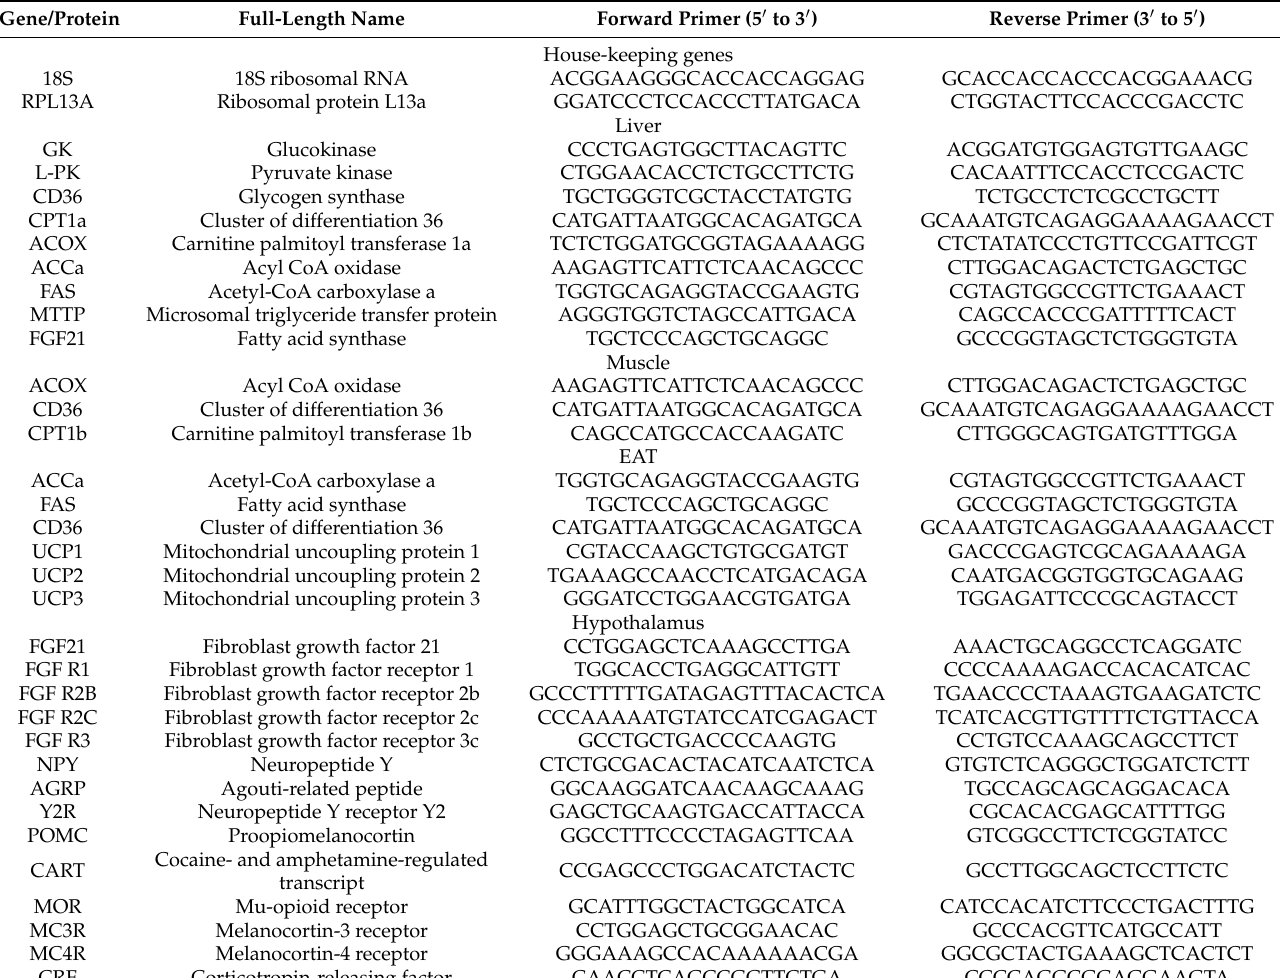
Table A3. Primer sequences used for mRNA expression measurement in liver, gastrocnemius muscle, EAT and